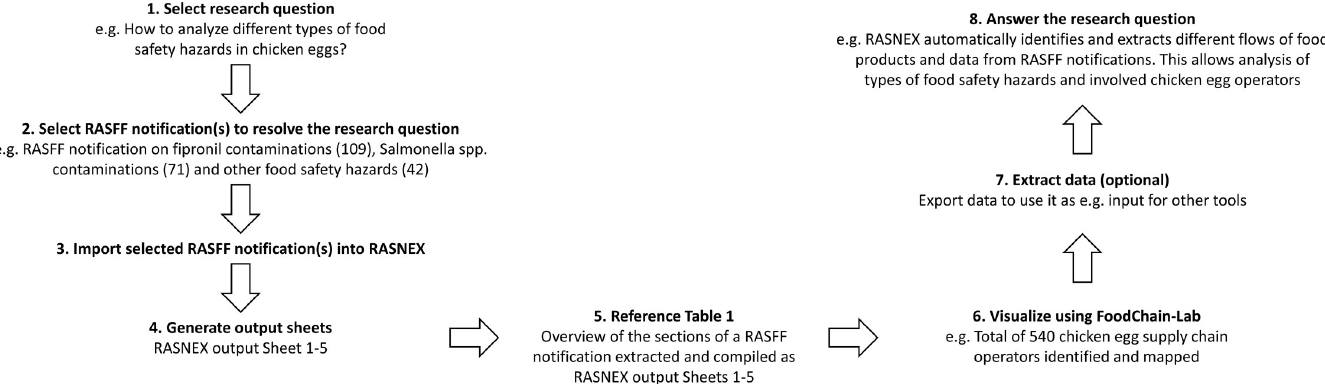
Fig 1. Methodological graphical scheme illustrating the functioning of RASNEX and the structure of this paper.